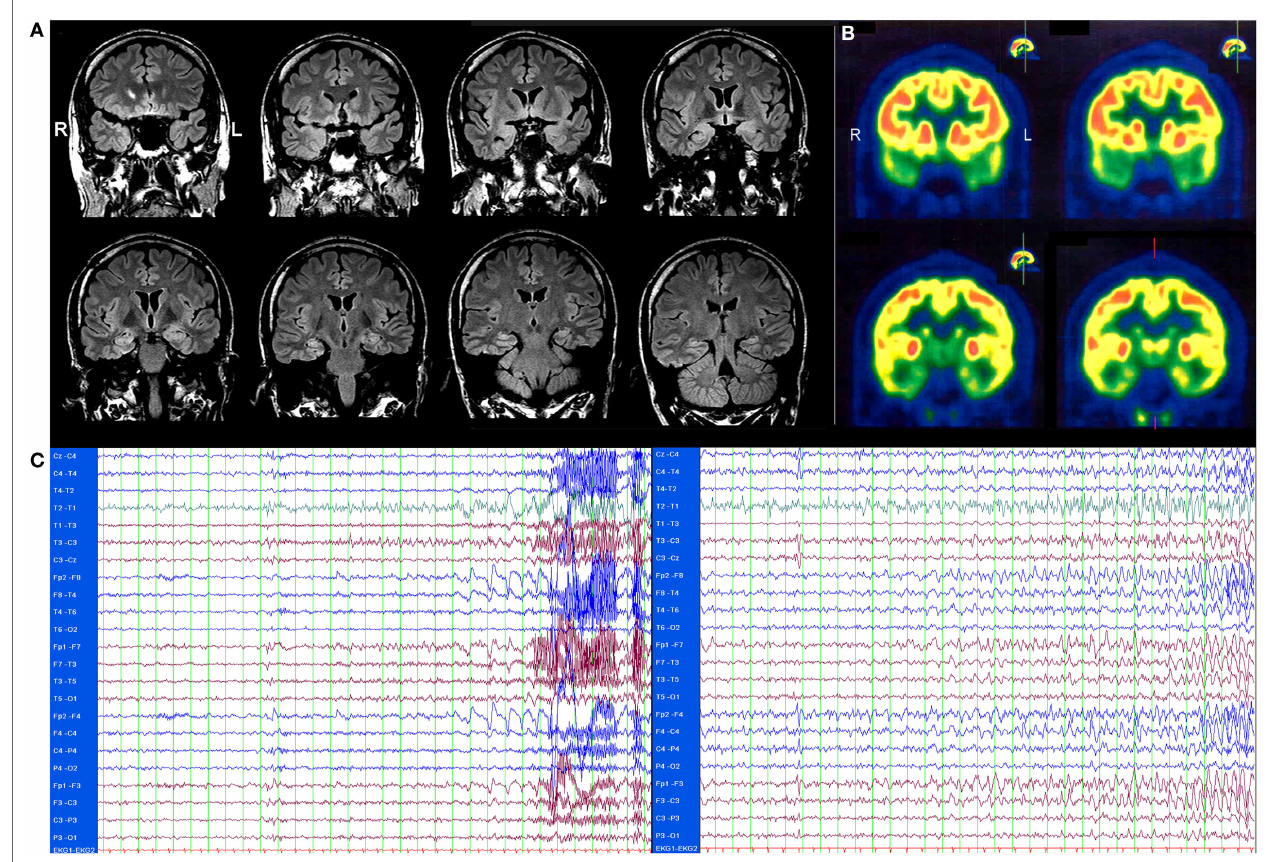
FiGuRe 1 | (a) Brain magnetic resonance imaging (MRI), T2/fluid attenuated inversion recovery (FLAIR) showing a distinct bilateral temporomesial hyperintensity without atrophy. (B) 2-fluoro-2-desoxy- d -glucose positron emission tomography (FDG-PET) showing a bitemporal (right > left), hypometabolism. Both images were scanned before therapy, in November 2011. (C) EEG of two seizures. One second per line. Left: seizure starting